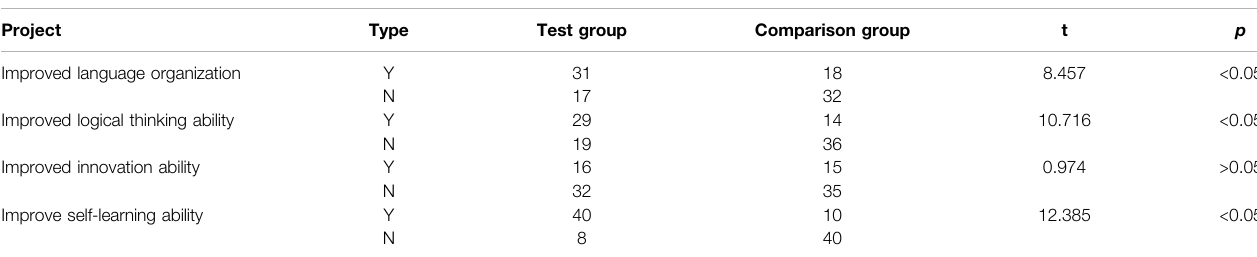
TABLE 8 | Comparison of the two groups of students after teaching.